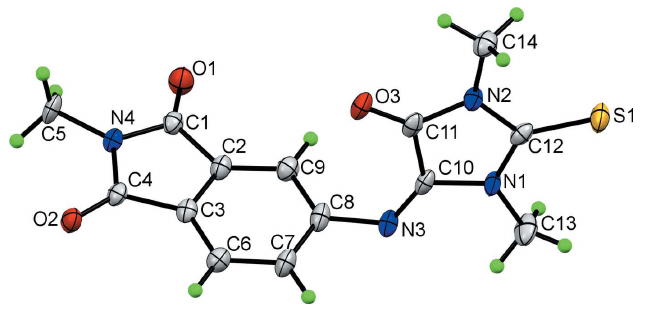
Figure 1 The molecular structure of 1 , showing 50% displacement ellipsoids.